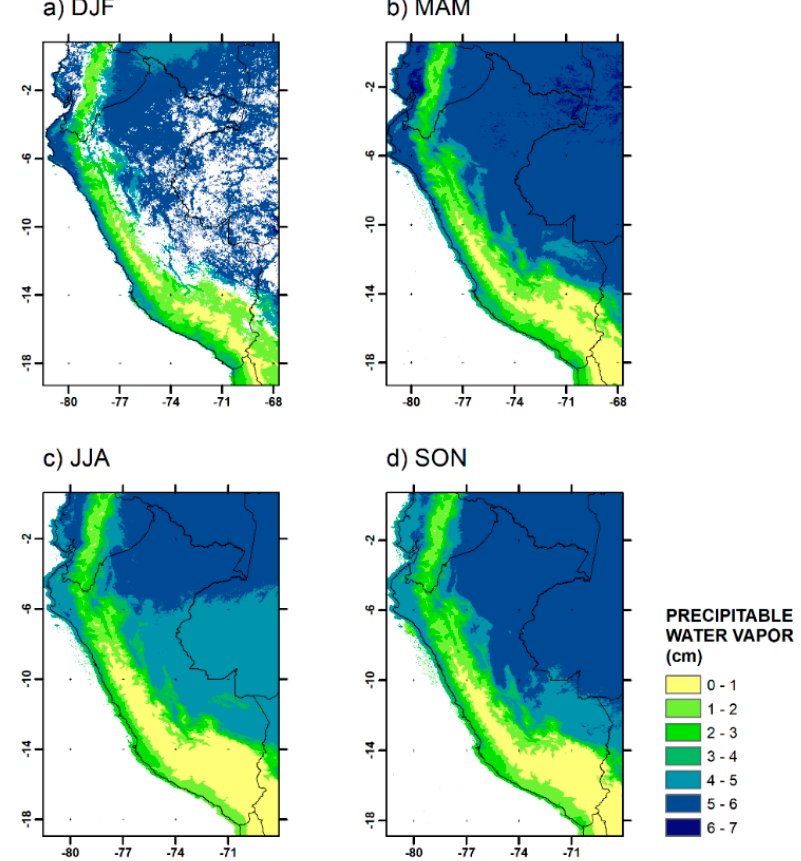
Figure 6. Spatial pattern of PWV over Peru for: ( a ) DJF, ( b ) MAM, ( c ) JJA and ( d ) SON seasons. Maps obtained from MODIS product.